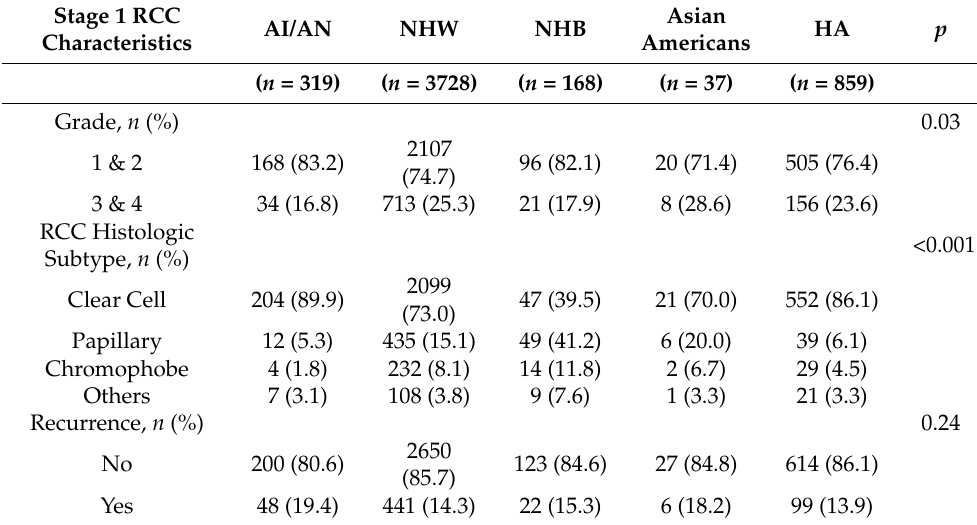
Table 2. Stage I RCC characteristics across racial/ethnic groups in Arizona Cancer